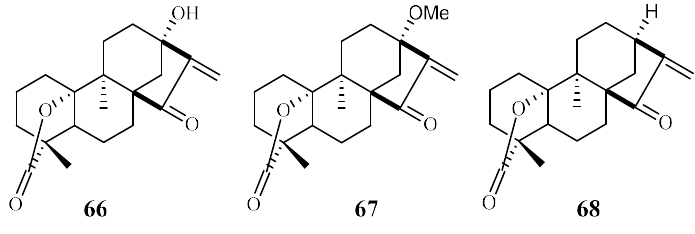
Figure 10. Compounds from a Chrysobalanaceae plant.